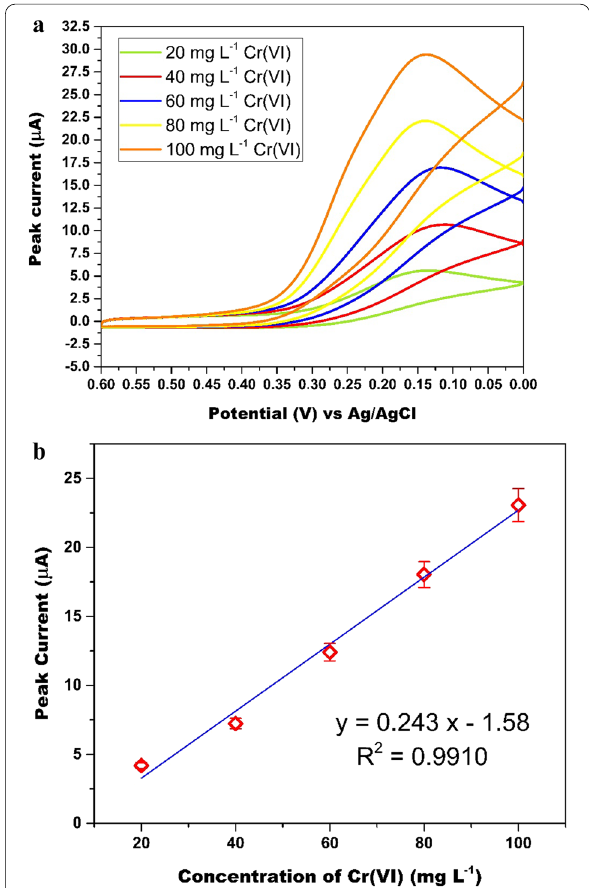
Fig. 4 a Cyclic voltammograms of Cr(VI) at different concentrations with scan rate of 0.1 V s − 1 in potential range of 0.0–0.6 V having sensitivity 0.001 AV − 1 . b Linear plot of Peak current versus concentration of Cr(VI)